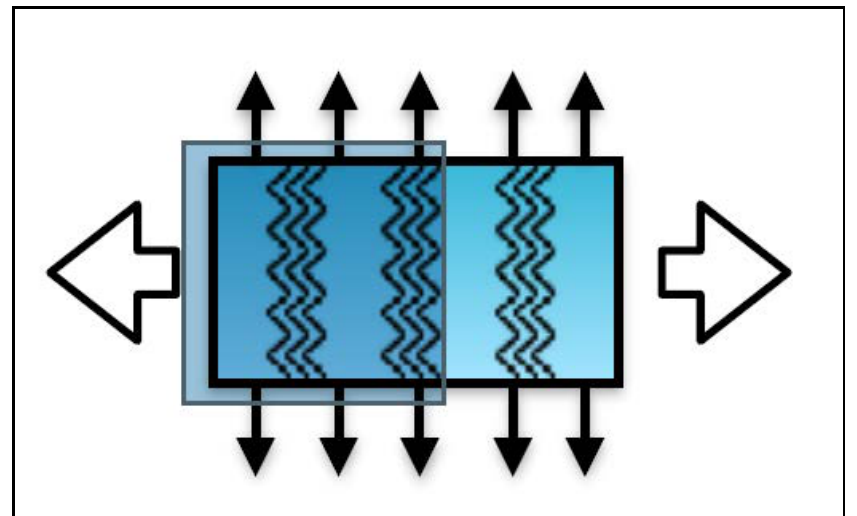
Figure 1. Foldable strips in a zig-zag way along the warp.